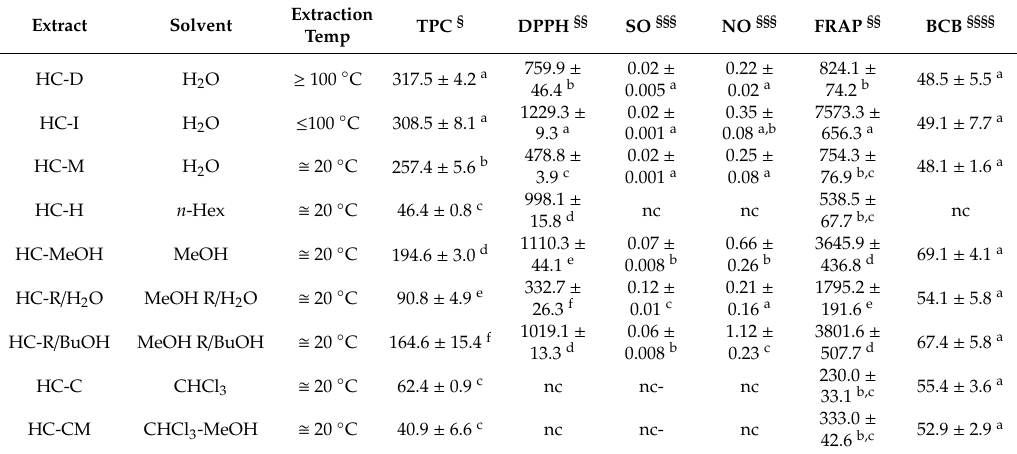
Table 1. Antioxidant activity of H. crepitans leaf